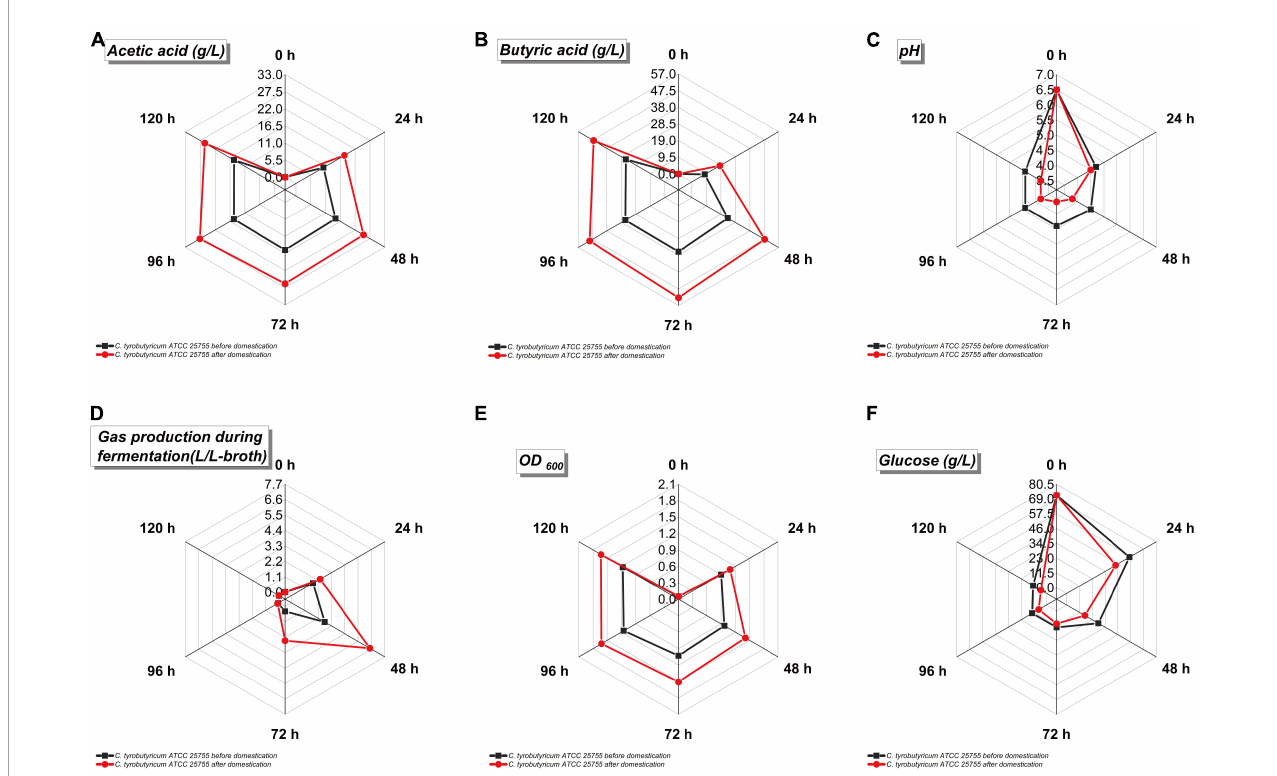
FIGURE5 Fermentation parameters of Clostridium tyrobutyricum before and after acclimation in refinery final molasses treated with 0.45 µ m nuclear pore membrane. The black is C. tyrobutyricum before domestication, and the red is C. tyrobutyricum after domestication. The five points on the radar chart in the figure are the sampling values at 0, 24, 48, 72, 96, and 120 h of shake flask fermentation. (A) Acetic acid production (g/L). (B) Butyric acid production (g/L). (C) pH value of fermentation broth. (D) Gas production during fermentation (L/L-broth). (E) Cell density of fermentation broth (OD 600 ). (F) Glucose concentration in fermentation